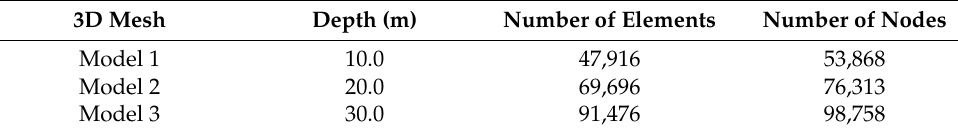
Figure 5. Backbone curve (Infill soil).